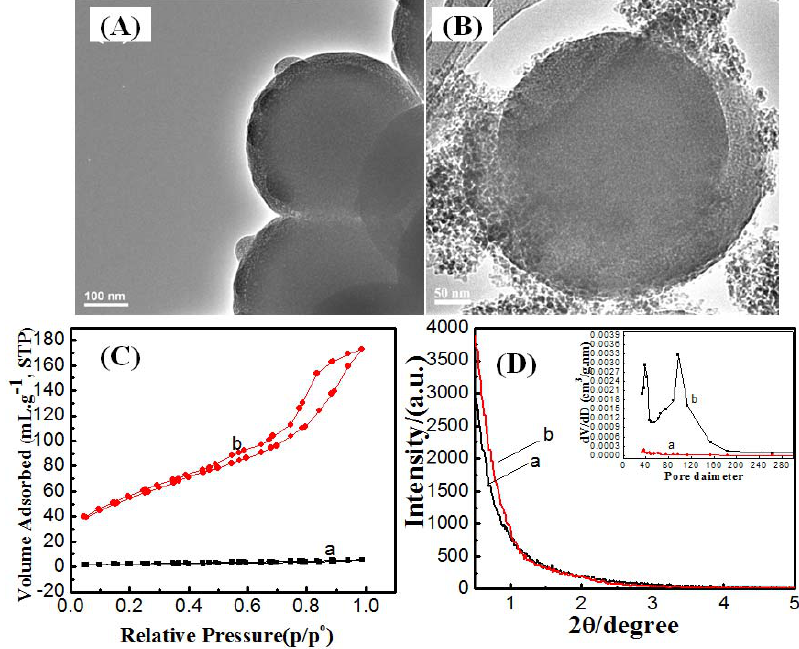
Figure 1. TEM images for mesoporous silica shell constructed on silica cores by ( A ) one-pot adsorption/desorption isotherms and ( D ) low synthesis and ( B ) two-pot synthesis; ( C ) N 2 X-ray diffraction patterns for mesoporous silica shell constructed on silica cores by ( a ) one-pot synthesis and ( b ) two-pot synthesis and pore-size distribution from the adsorption branch